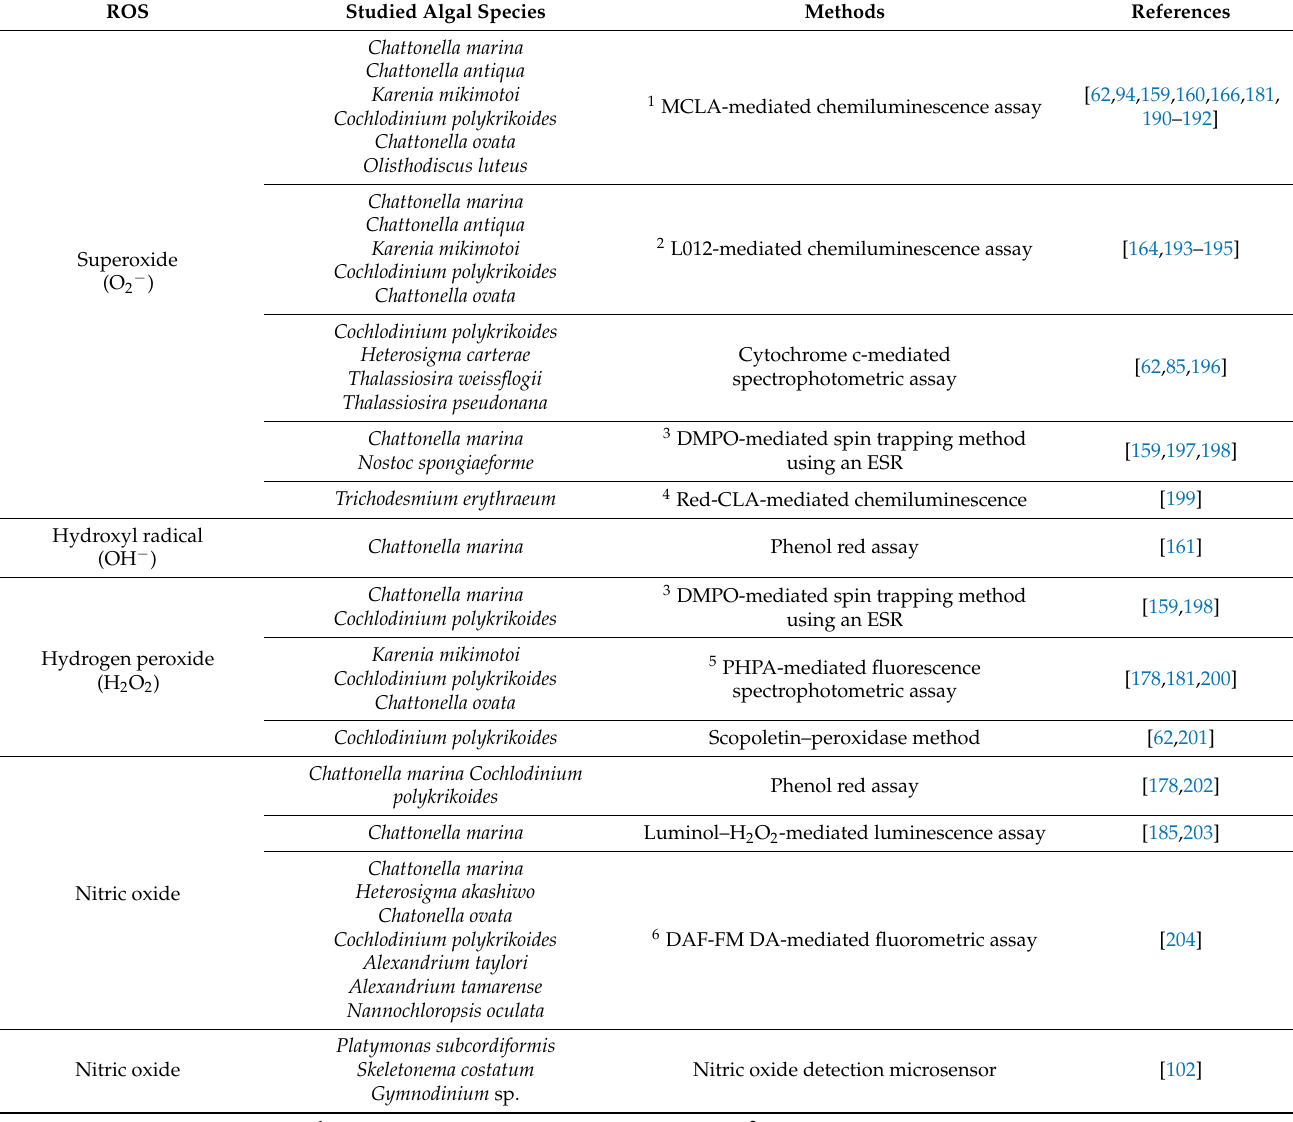
Table 2. List of assay methods used for the detection of reactive oxygen species (ROS) in microalgae. ROS Studied Algal Species